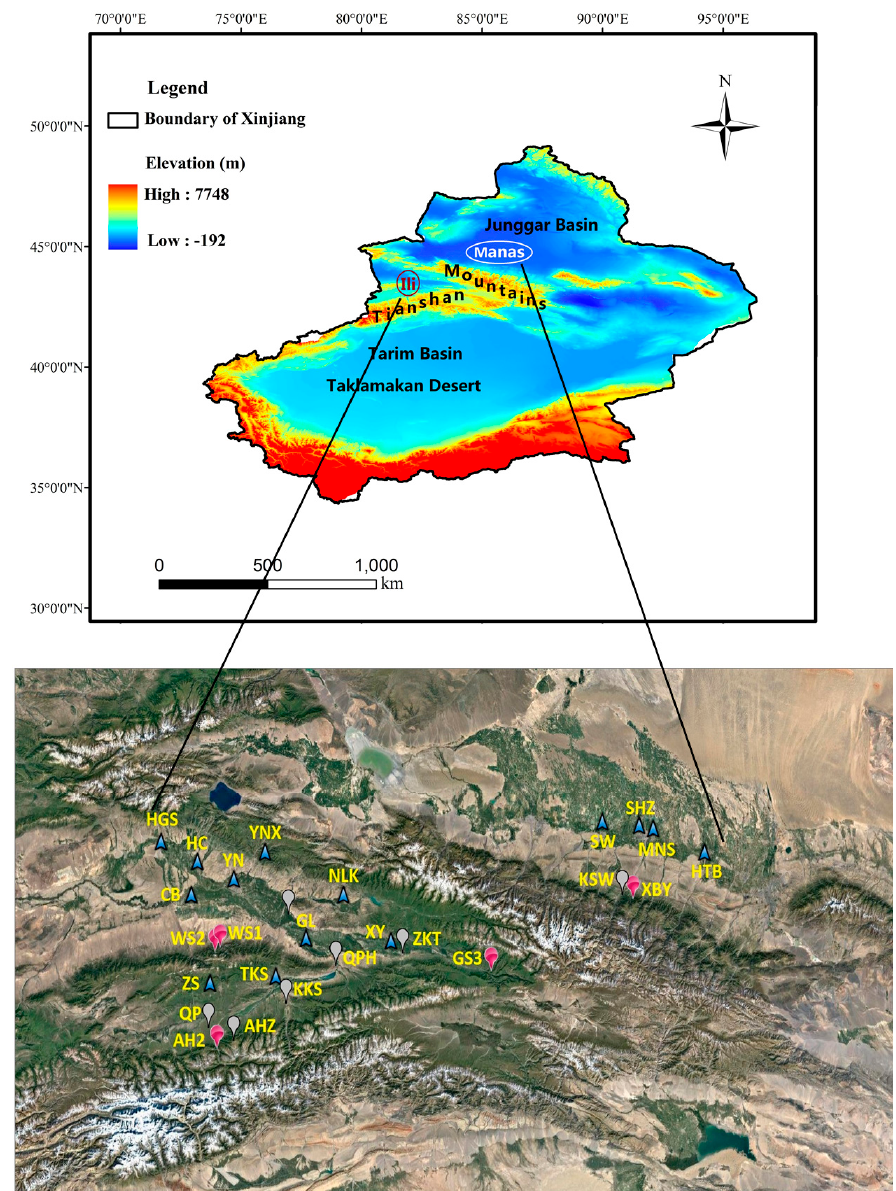
Figure 1. Map of the climate station (blue triangle), hydrological station (white circle) and the sampling sites (red circle) on the North Tianshan Mountain, Xinjiang China (yellow abbreviations represent the site ID of stations).